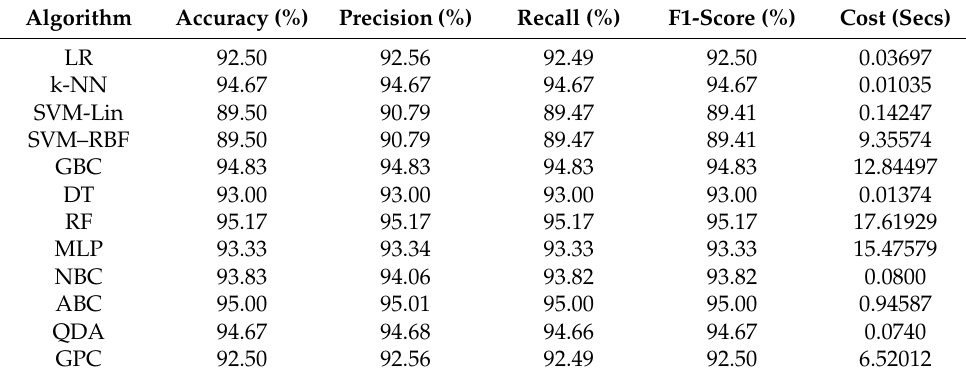
Table 3. Global performance comparison of ML